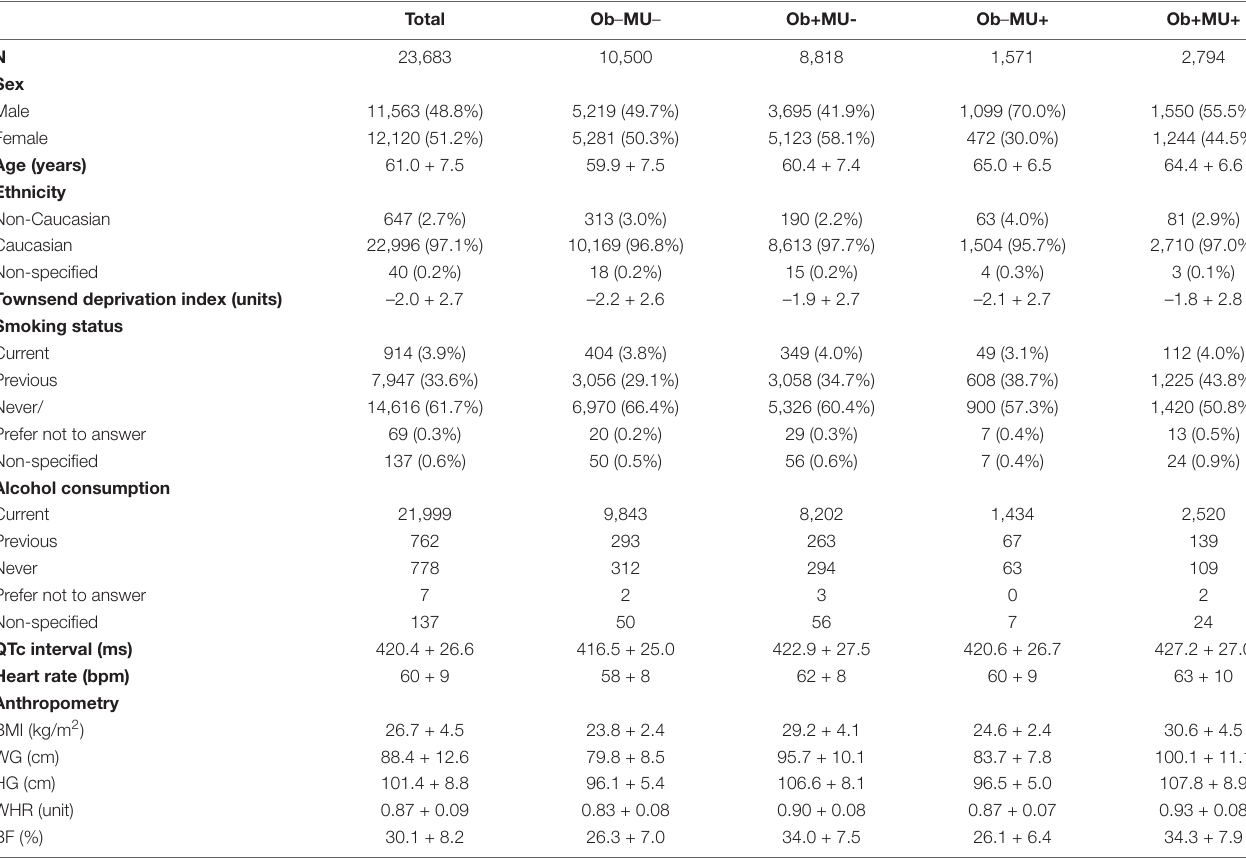
TABLE 1 | The characteristics of the UK Biobank participants in whom the effects of adiposity and clinical phenotype on QTc interval was assessed. Total Ob – MU – Ob+MU- Ob – MU+